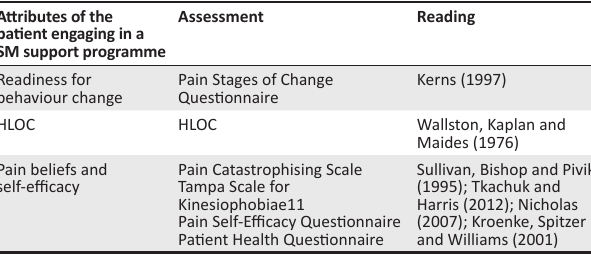
in SM programmes need. TABLE 2: Attributes that participants most likely need to engage in successful self-management. Attributes of the Assessment patient engaging in a SM support programme